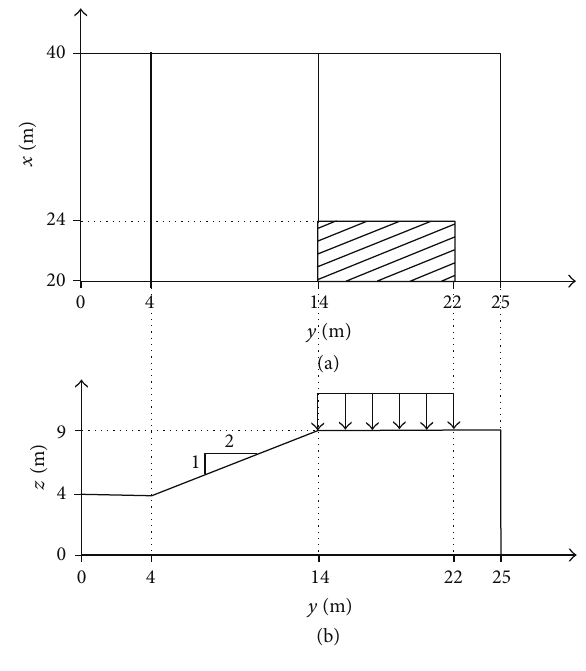
Figure 16: (a) Half-plan view and (b) central cross-section of slope in example problem 2.